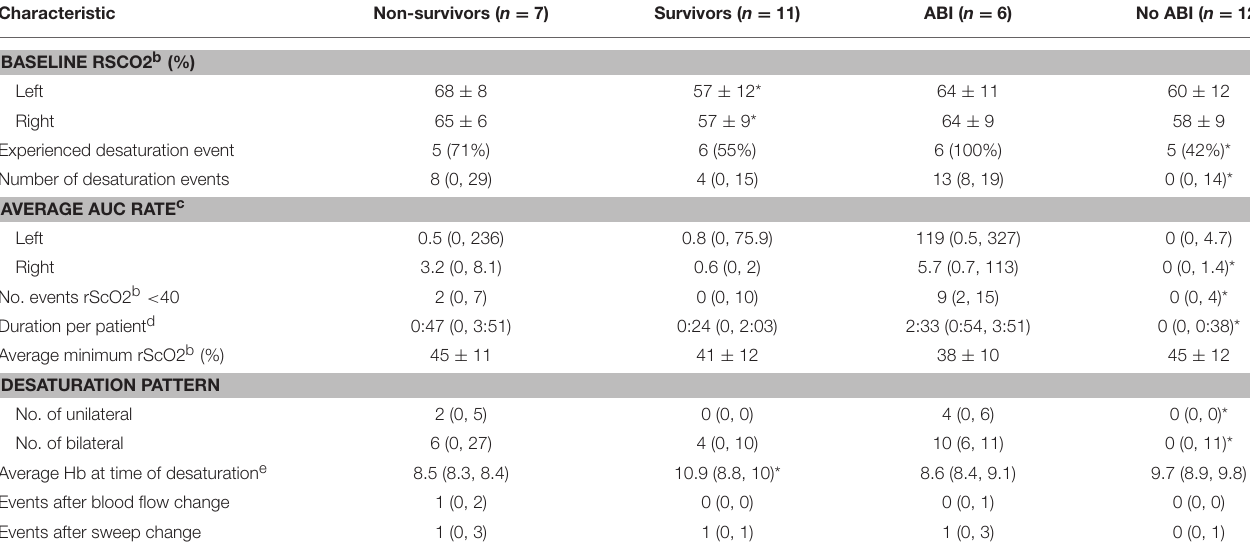
TABLE 2 | Regional brain oxygenation values a .